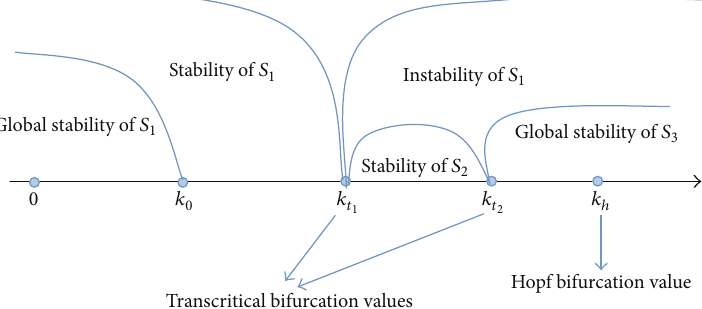
Figure 2: (1) Equilibria 𝑆 0 and 𝑆 1 always exist, where 𝑆 0 is unstable. (2) When 0 < 𝑘 < 𝑘 𝑡 , 𝑆 1 is stable; when 0 < 𝑘 < 𝑘 0 , 𝑆 1 is globally 1 , 𝑆 1 is unstable. (3) When 𝑘 = 𝑘 𝑡 , equilibrium point 𝑆 2 is branched out from 𝑆 1 ; 𝑘 = 𝑘 𝑡 is a transcritical asymptotically stable; when 𝑘 > 𝑘 𝑡 1 1 1 , equilibrium point 𝑆 2 is asymptotically stable. (5) When 𝑘 = 𝑘 𝑡 , equilibrium point 𝑆 3 is branched bifurcation value. (4) When 𝑘 1 < 𝑘 < 𝑘 𝑡 2 2 is a transcritical bifurcation value. (6) When 𝑘 > 𝑘 𝑡 , 𝑆 3 is globally asymptotically stable. (7) 𝑘 = 𝑘 ℎ is a Hopf bifurcation out from 𝑆 2 ; 𝑘 = 𝑘 𝑡 2 2 value of 𝑆 2 .